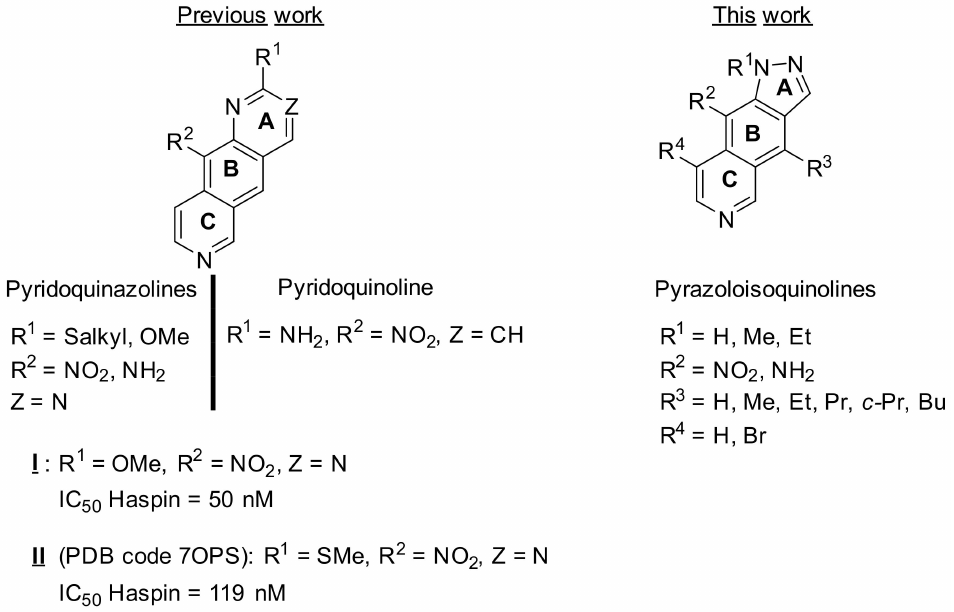
Figure 1. Structure of pyridoquinazolines and pyridoquinoline with Haspin inhibitory potency previously described by our group. Structure of new pyrazolo[3,4- g ]isoquinolines described in this